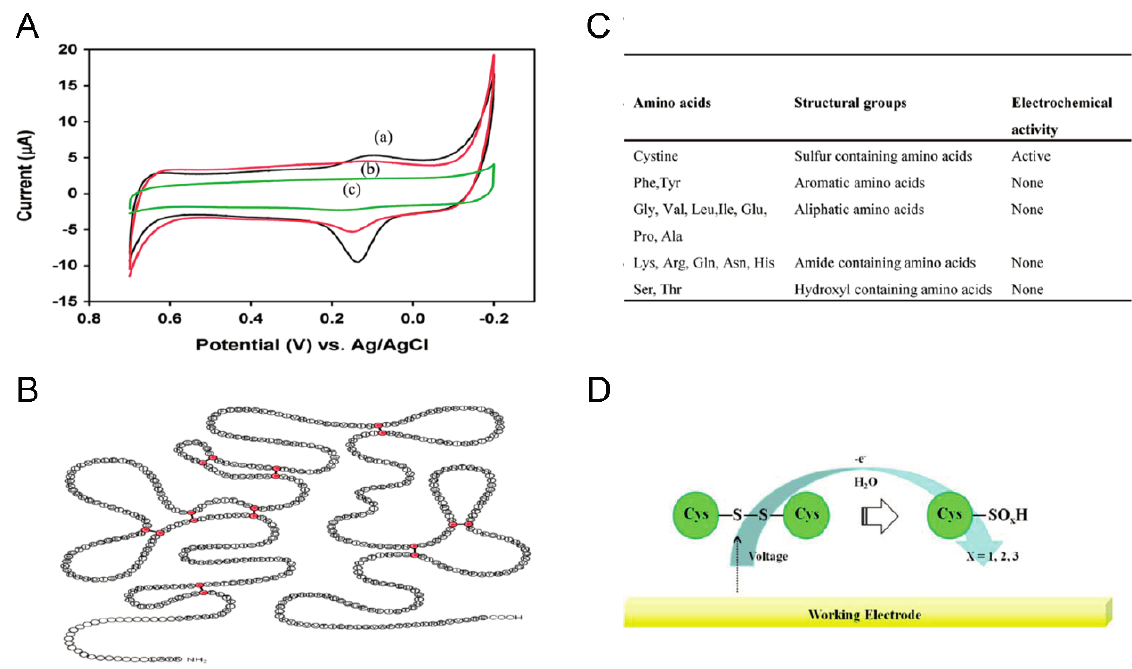
Figure 2. Electrochemical detection of HIV-1 virus based on direct electron transfer using Au nano dot A. Cyclic voltammogram of fabricated biosurface on an Au nanoparticle modified ITO electrode. ( A ) Bare Au nanoparticle modified ITO electrode; ( B ) fragmented Antibody; ( C ) HIV-1 VLPs, respectively, Schematic representation of B. the structure of gp120, C. expected electrochemical oxidation of disulfide bond and ( D ) Electrochemical activity of various amino acids. Figure reproduced with permission from [28], © 2013